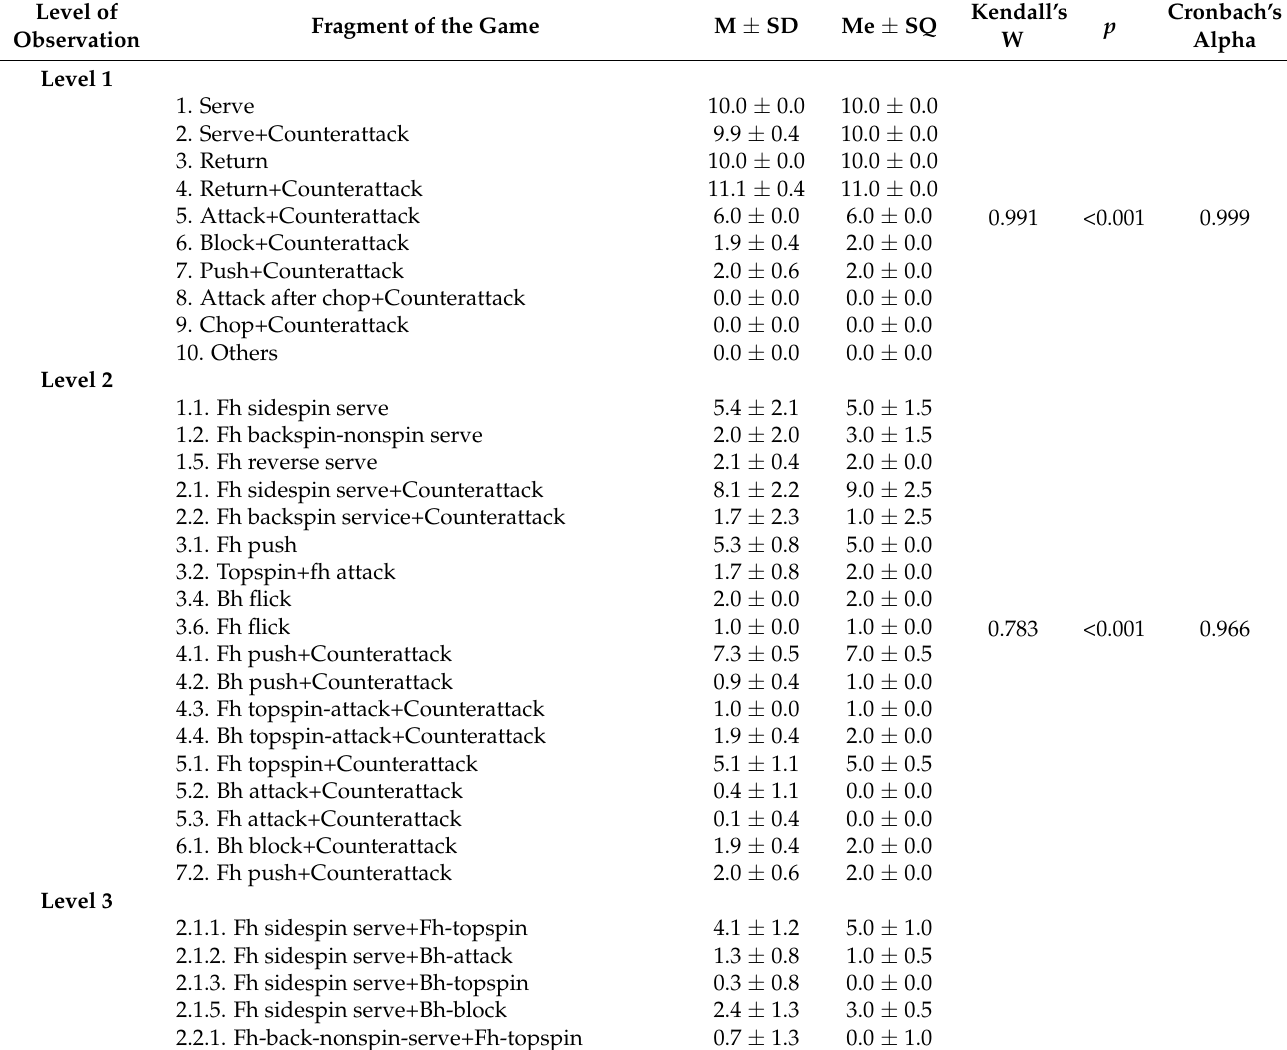
Table 2. Descriptive statistics and reliability assessment—the number of individual actions (game fragments) classified by experts (n = 7)—for the observations of Ma